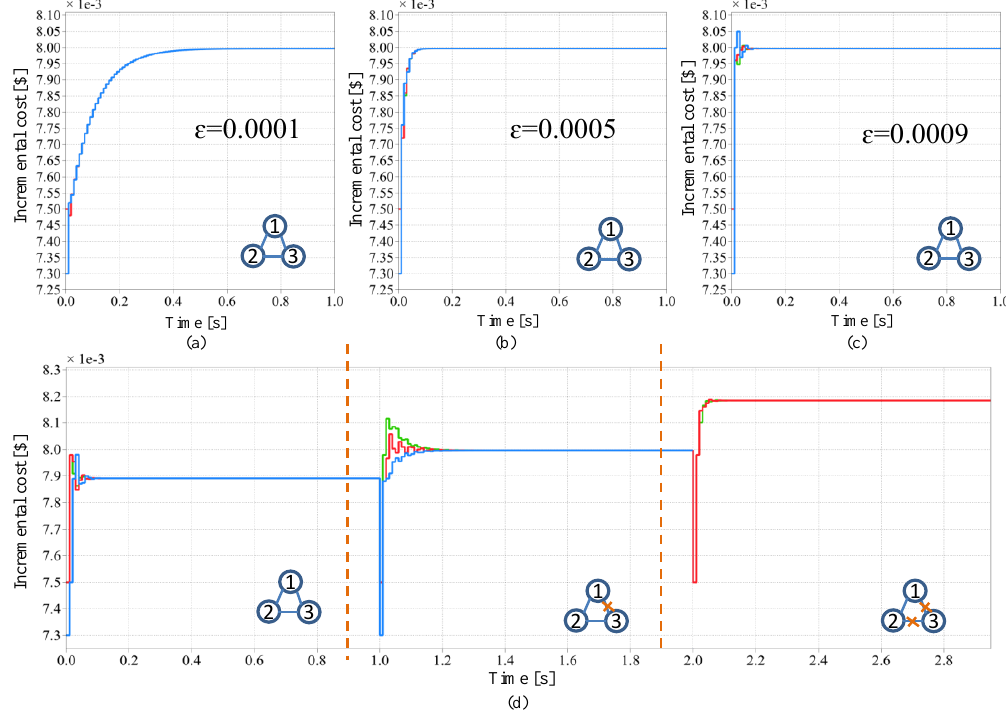
Figure 8. Consensus dynamics with different ε an d topologies: ( a ) convergence curve with ε = 0.0001; ( b ) convergence curve with ε = 0.0005; ( c ) convergence curve with ε = 0.0009; and ( d ) convergence curve with changing topologies.